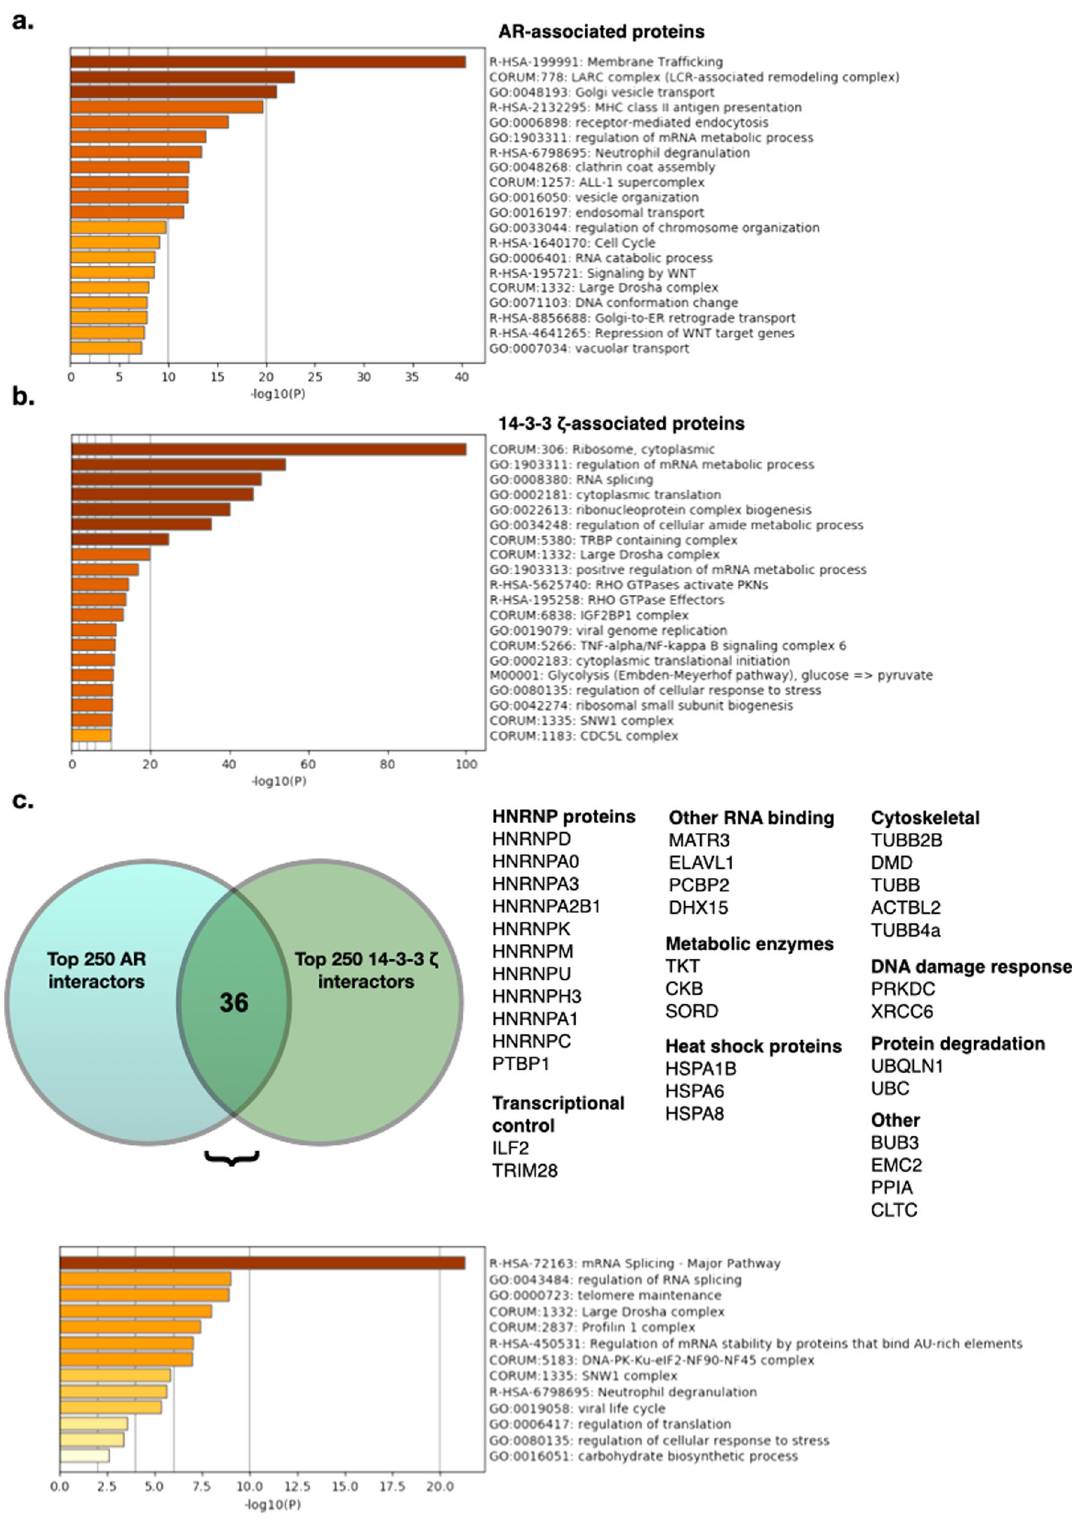
Fig. 7 AR and 14-3-3 ζ share interactions on chromatin with a variety of proteins, including AR co-regulators. a AR RIME in LNCaP cells indicates interactions with proteins involved in a variety of processes, including mRNA processing and transcriptional pathways including the LARC complex and WNT signaling. b 14-3-3 ζ interacts on chromatin with proteins mainly involved in ribosomal and RNA processing, as well as a variety of other complexes. c The overlap between 14-3-3 ζ and AR interactions in PIM1 over-expressing LNCaP cells includes 36 proteins, including HNRNP proteins, other RNA binding proteins, and known AR co-regulators such as hnRNPK and TRIM28. Proteins involved in mRNA splicing are the main pathways identi fi